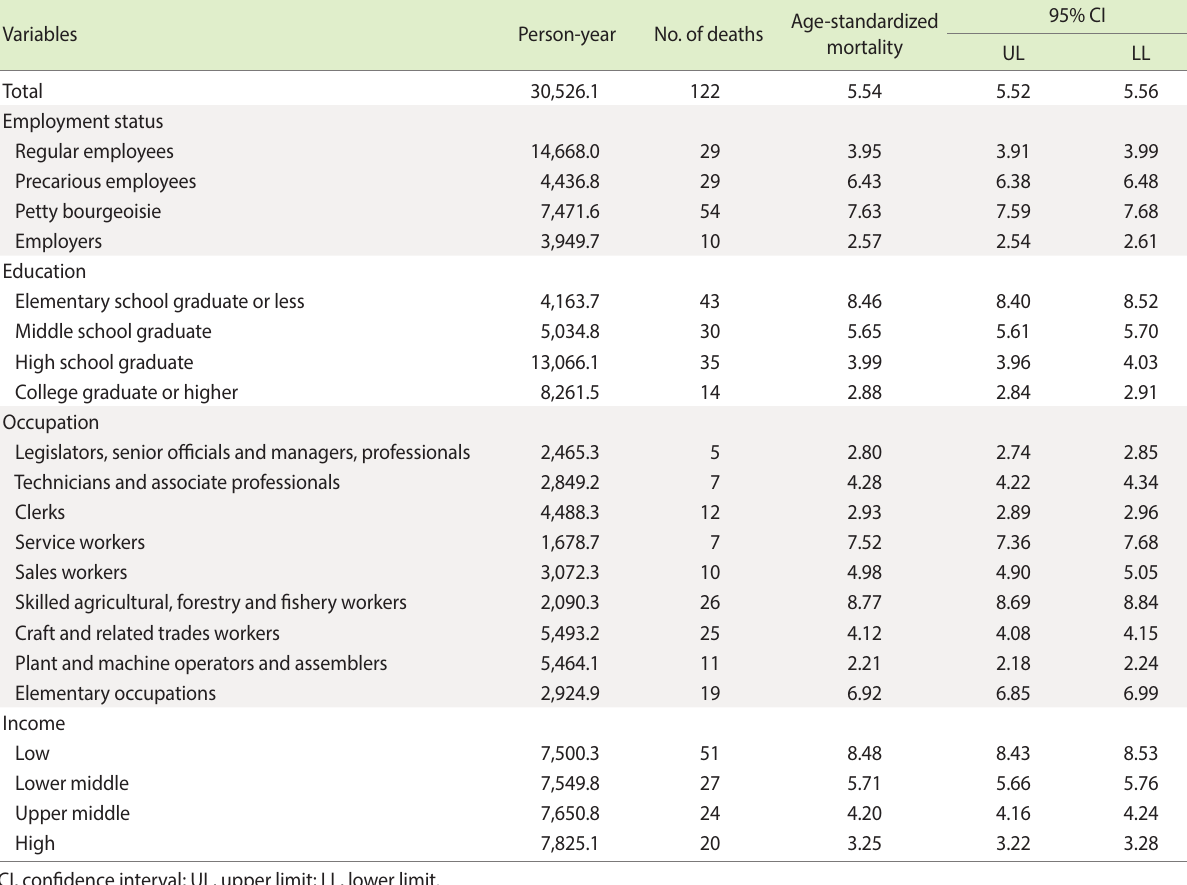
Table 2. Age-standardized mortality rates (per 1,000 person-years) in 2000-2012 by employment status and other socioeconomic indicators among employed men aged 30-69 years in 1999